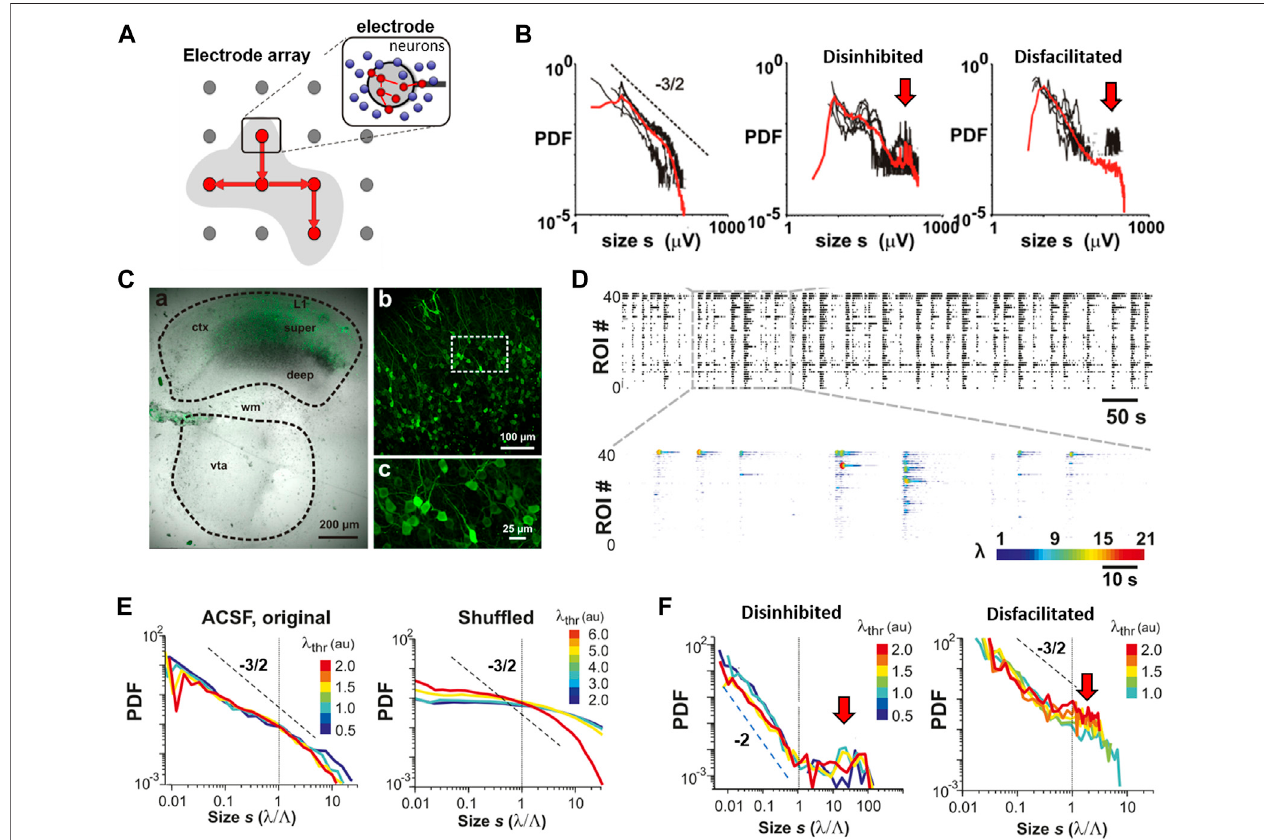
FIGURE13| Experimentaltransitionfromsingle-nLFPavalanchestospikeavalanchesinorganotypiccortexculturesusingtwo-photonimaging(2PI). (A) Sketchof spatial transformation of propagated nLFPs on the electrode array to propagated spike activity in local neuronal groups ( circles ; red : spiking; blue : quiet) within the neighborhood of a single electrode ( zoom ). (B) Distribution of nLFP amplitudes at single electrodes ( red : average; black : example single electrodes). Power-law – like distributions change into bimodal distributions when reducing inhibition ( disinhibited ) or excitation ( disfacilitated ) (reproduced with permission from [11]). (C) – (F) Reconstruction ofspike avalanches inanorganotypiccortex culture. (C) Single organotypic cocultureofthecortex( ctx )and ventral tegmentalarea ( VTA ) after ∼ 3weeks grown postnatal. Electroporation of the embryo at E16.5 leads to expression of the genetically encoded calcium indicator YC2.6 in pyramidal neurons from super fi cial cortex layers ( b and c are successive zooms from a ). Broken lines : tissue borders. wm : white matter. (D) Raster of spontaneous spike density monitored with 2PI and obtainedthroughdeconvolution ( n (cid:2) 40pyramidalneurons). Top :binarizedraster. Bottom :temporallyexpandedrastersegmentedwithcolorcodedspike intensity λ for each neuron. (E) Spontaneous neuronal activity reveals power laws in spike avalanches that are robust to the threshold λ thr applied at the single neuron level ( left ). Temporal shuf fl ing of spike activity abolishes the power law in avalanche sizes ( right ). (F) Mild disinhibition changes the power law to a bimodal distribution with an initial steep slope of − 2 and system-wide population events ( red arrow ; cf. Figure 5E ). System-wide events also become prominent when mildly reducing excitation ( right ). (modi fi ed for C and C – F reproduced under CC0 license from